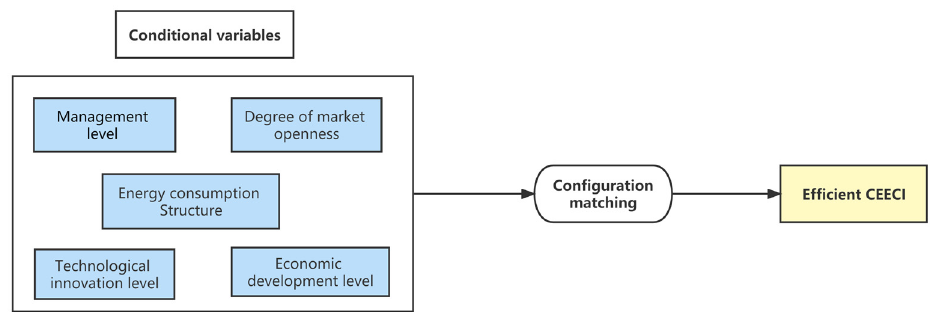
Figure 1. Research Figure 1. Research framework.